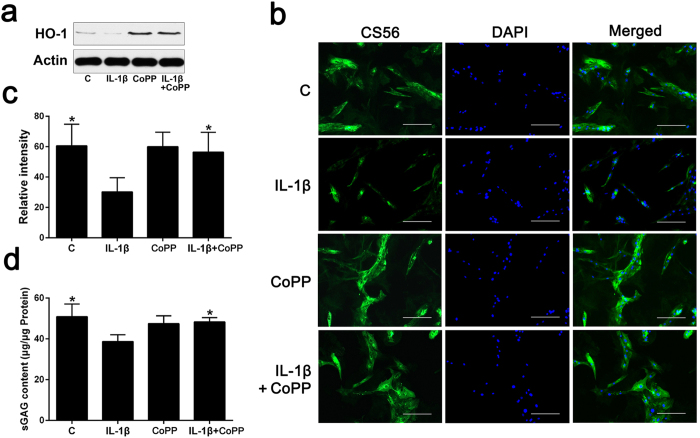
Effects of CoPP on HO-1 expression and sGAG synthesis in human NP cells (a) Western blot analysis revealed that HO-1 protein levels were remarkably increased by CoPP in the presence or absence of IL-1β. (b,c) Immunofluorescence microscopy showed that the immunostaining and relative immunofluorescence intensity of CS, the major component of sGAG, were lower after IL-1β stimulation and this effect was ameliorated by HO-1 induction (bars = 100 μm). (d) DMMB assay showed that the HO-1 inducer CoPP considerably rescued the loss of sGAG content caused by IL-1β without influencing basal sGAG synthesis. Values represent the mean and SD. *P < 0.05 with respect to IL-1β.